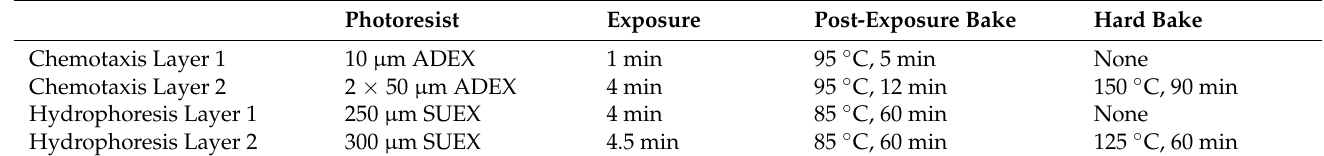
Table 1. Process parameters for various dry film photoresist types and layer thicknesses.